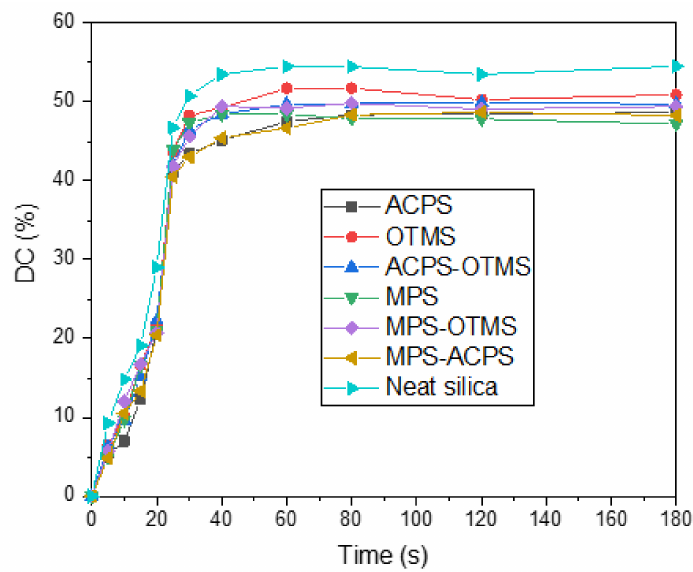
Figure 6. Degree of conversion (DC %) versus curing time for the experimental dental nanocomposite resins reinforced with 60 wt% of different types of silica